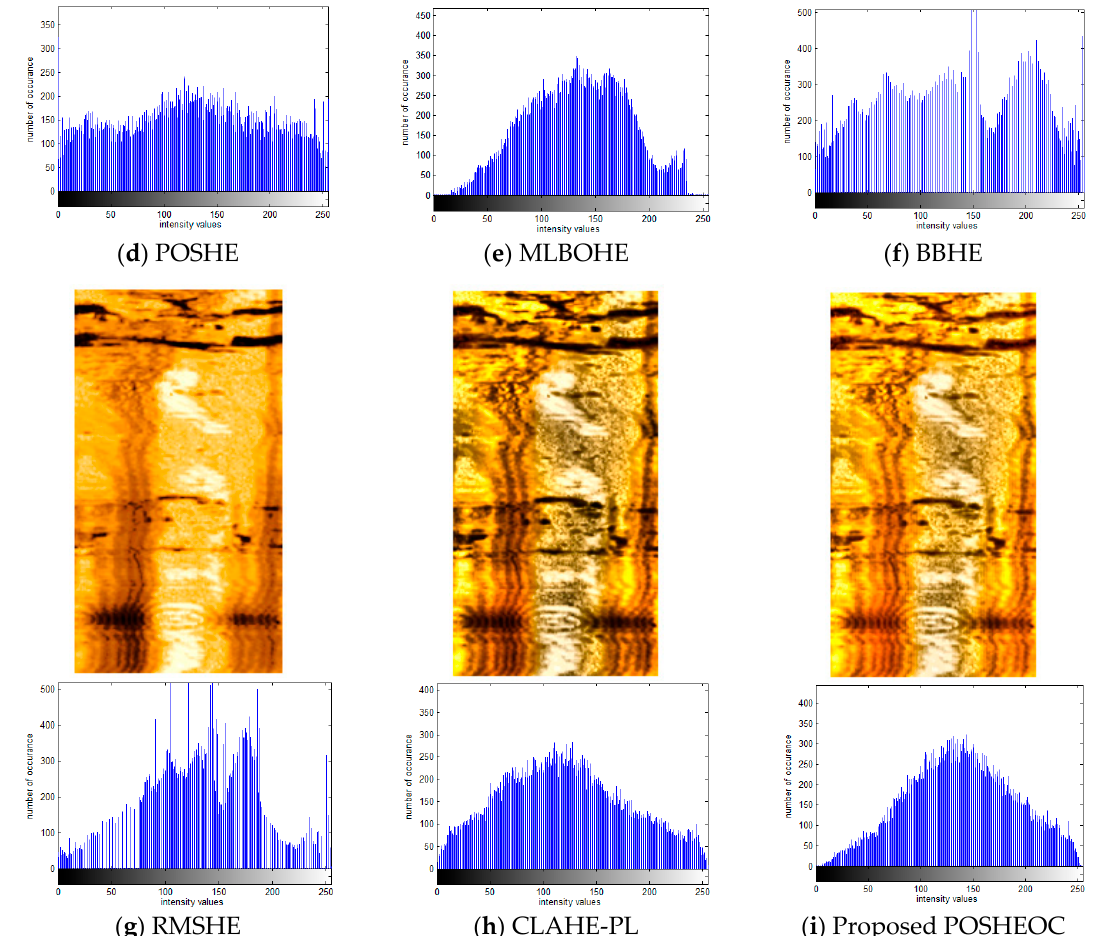
Figure 9. Comparison of enhancement results with corresponding statistical histogram using various techniques for ultrasonic logging image of Changqingli well. ( a ) Original image; ( b ) HE; ( c ) BOHE; ( d ) POSHE; ( e ) MLBOHE; ( f ) BBHE; ( g ) RMSHE; ( h ) CLAHE-PL; ( i ) Proposed POSHEOC.